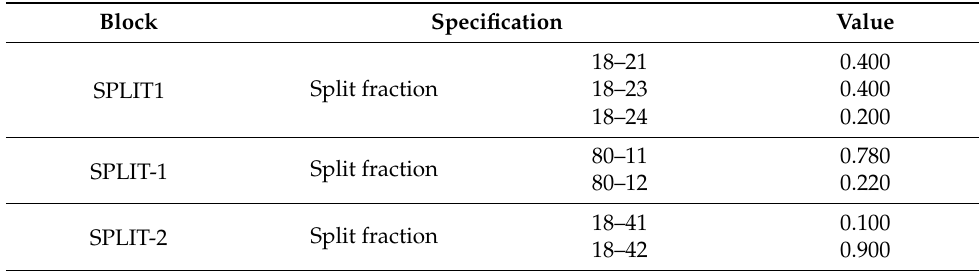
Table 7. Specifications of the splitter in the final wastewater heat recovery system.